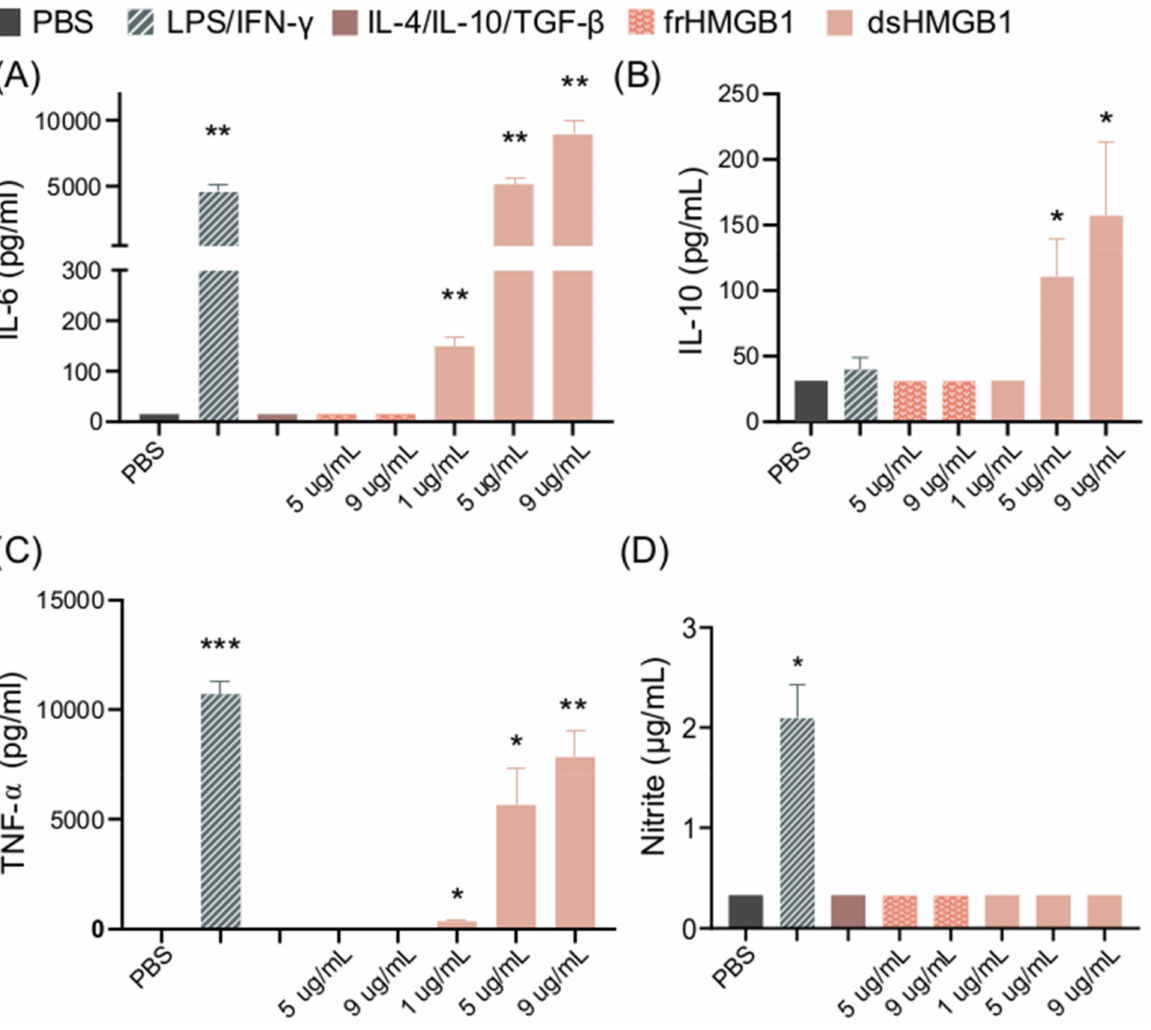
Figure 2. dsHMGB1 induces cytokine secretion but not nitrite production. ( A ) IL-6, ( B ) IL-10, ( C ) TNF- α , and ( D ) nitrite production by BMDMs in response to dsHMGB1 and frHMGB1 after 24 h incubation. Data represent n = 3–4 (mean + SD). Statistical analysis was performed using a one-sample t -test. * p ≤ 0.05, ** p ≤ 0.01, *** p ≤